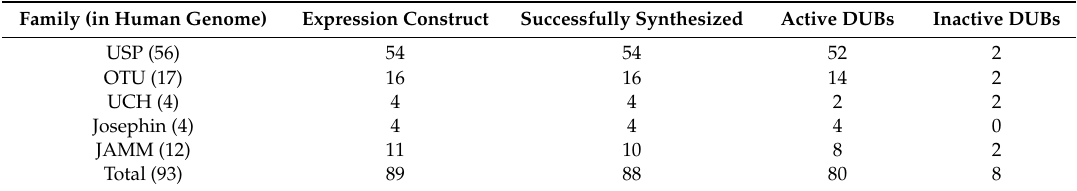
Table 1. Summary of the expression of recombinant deubiquitinating enzymes (DUBs) and the in vitro DUB assay. USP: ubiquitin specific protease; OTU: ovarian tumor domain containing protease;